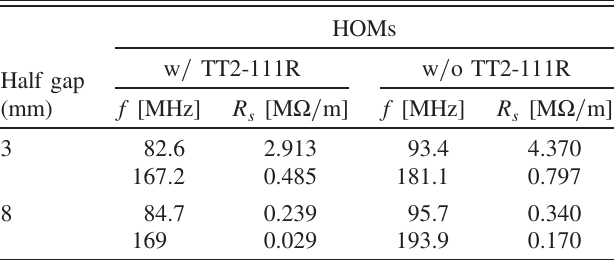
TABLE II. Summary of the first 2 HOM frequencies f and transverse shunt impedances R s for 3 mm and 8 mm half gaps from G dfid L